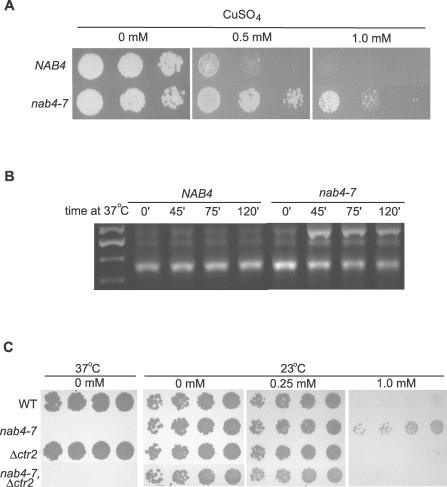
Nab4 and Alternative 3′ Pre-mRNA Processing Plays a Role during Copper Stress(A) Serial dilutions of NAB4 and nab4-7 strains on plates containing 0, 0.5, and 1 mM CuSO4. Cells were grown at room temperature which is the permissive temperature for the nab4-7 strain.(B) 3′ RACE of the CTR2 transcript during a shift to 37 °C of NAB4 and nab4-7 strains. Samples were taken at 0, 45, 75, and 120 min after shifting both strains to 37 °C, the non-permissive temperature of the nab4-7 strain. The RACE analysis displays three isoforms which correlate with the presence of three Nab4 motifs in the CTR2 3′ UTR. 100-base pair molecular weight markers are shown in lane 1 with the 300-base pair ladder visible at the bottom of the gel.(C) Serial dilutions of the wild-type NAB4, the single mutant nab4-7, the single mutant Δctr2, and the double mutant nab4-7 Δctr2 strains. The plating conditions are 23 °C, 37 °C, 1 M CuSO4, and 0.25 M CuSO4. WT, wild-type.